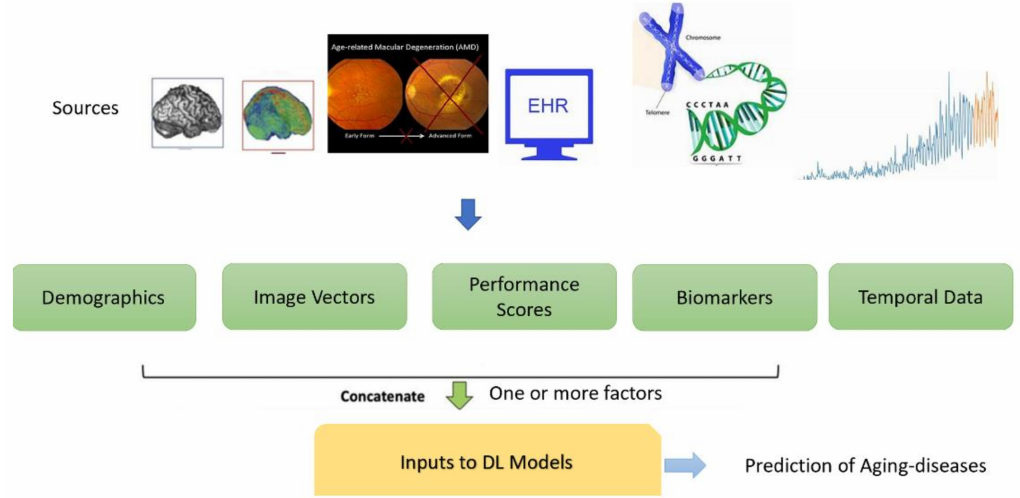
Figure 8. Multimodal feature vectors input to DL methods applied for predicting aging-related